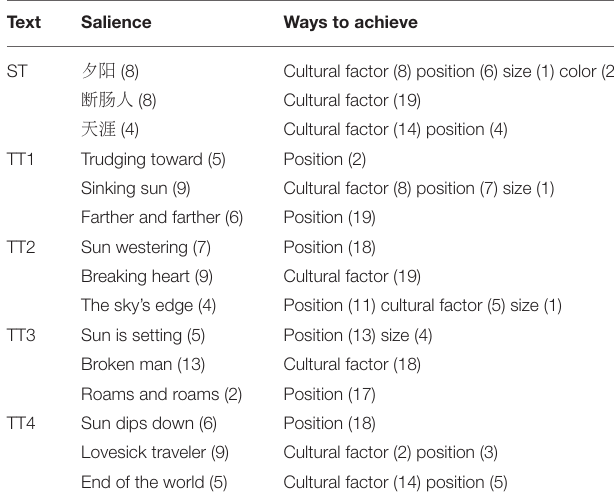
TABLE 2 | Distribution of imagery salience of